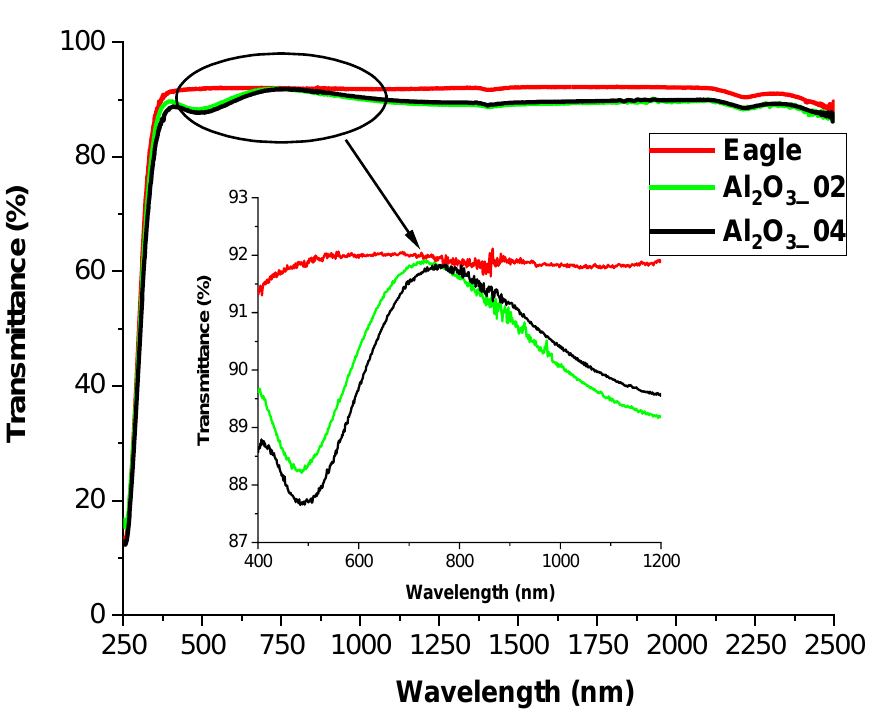
Figure 5. Comparison between the transmittance curves of glass substrate and Al 2 O 3 samples deposited in the same experimental conditions.